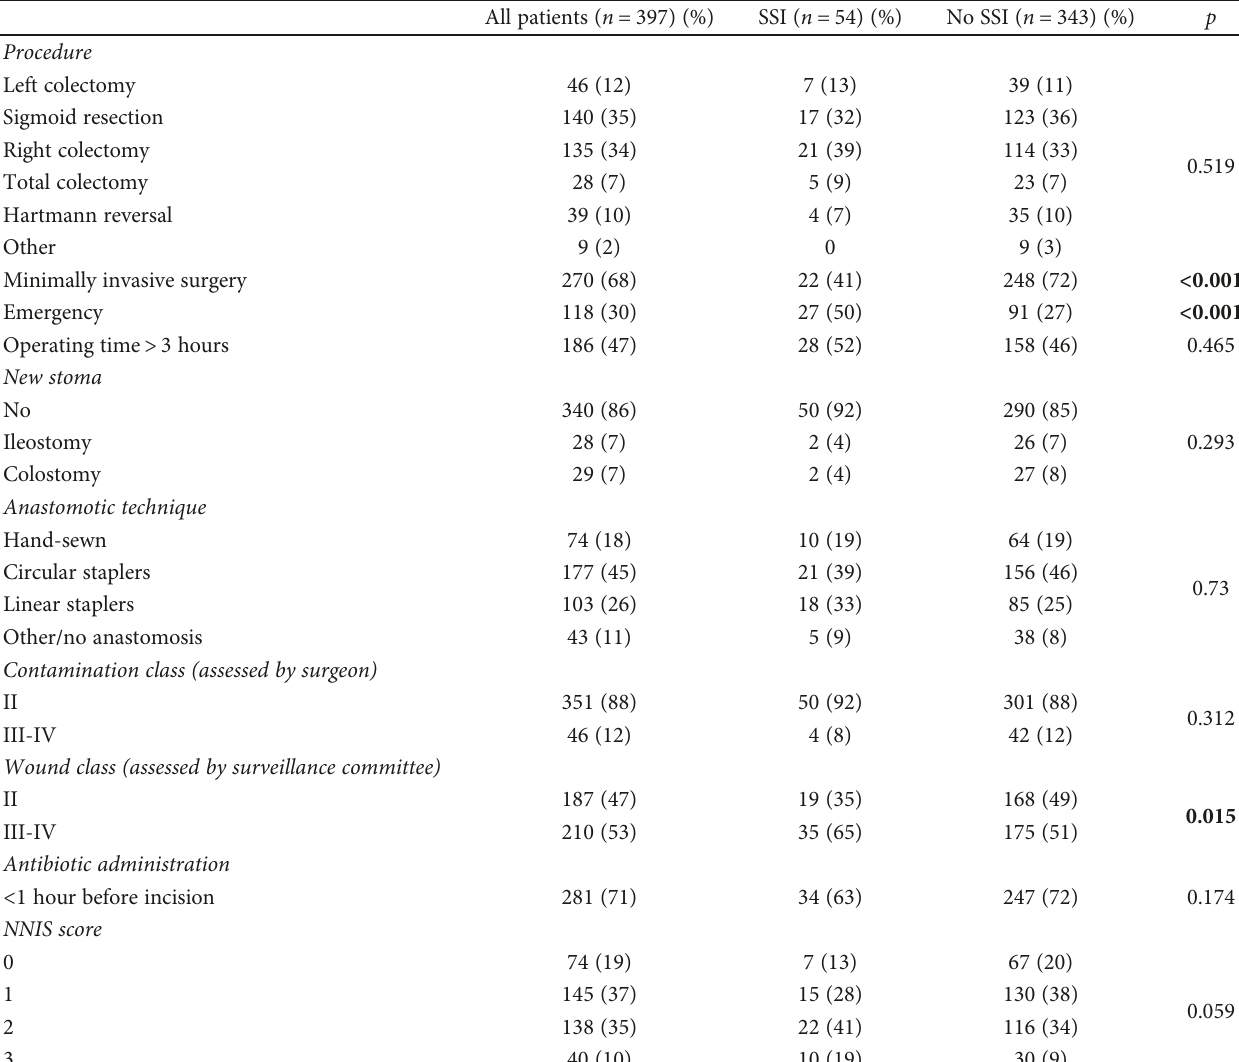
Table 2: Surgical